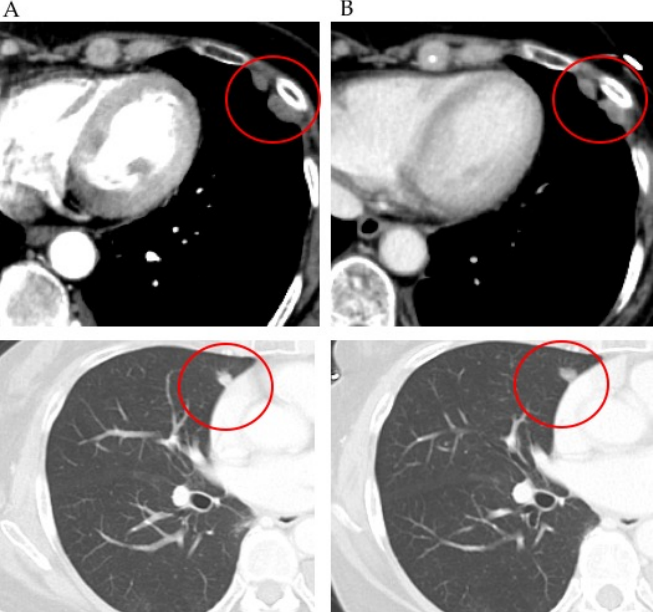
Figure 2. ( A ) Chest computed tomography showing a lung metastatic lesion before everolimus treatment. ( B ) Chest computed tomography showing a shrunken lung metastatic lesion, treated with everolimus, at the end of the first month.